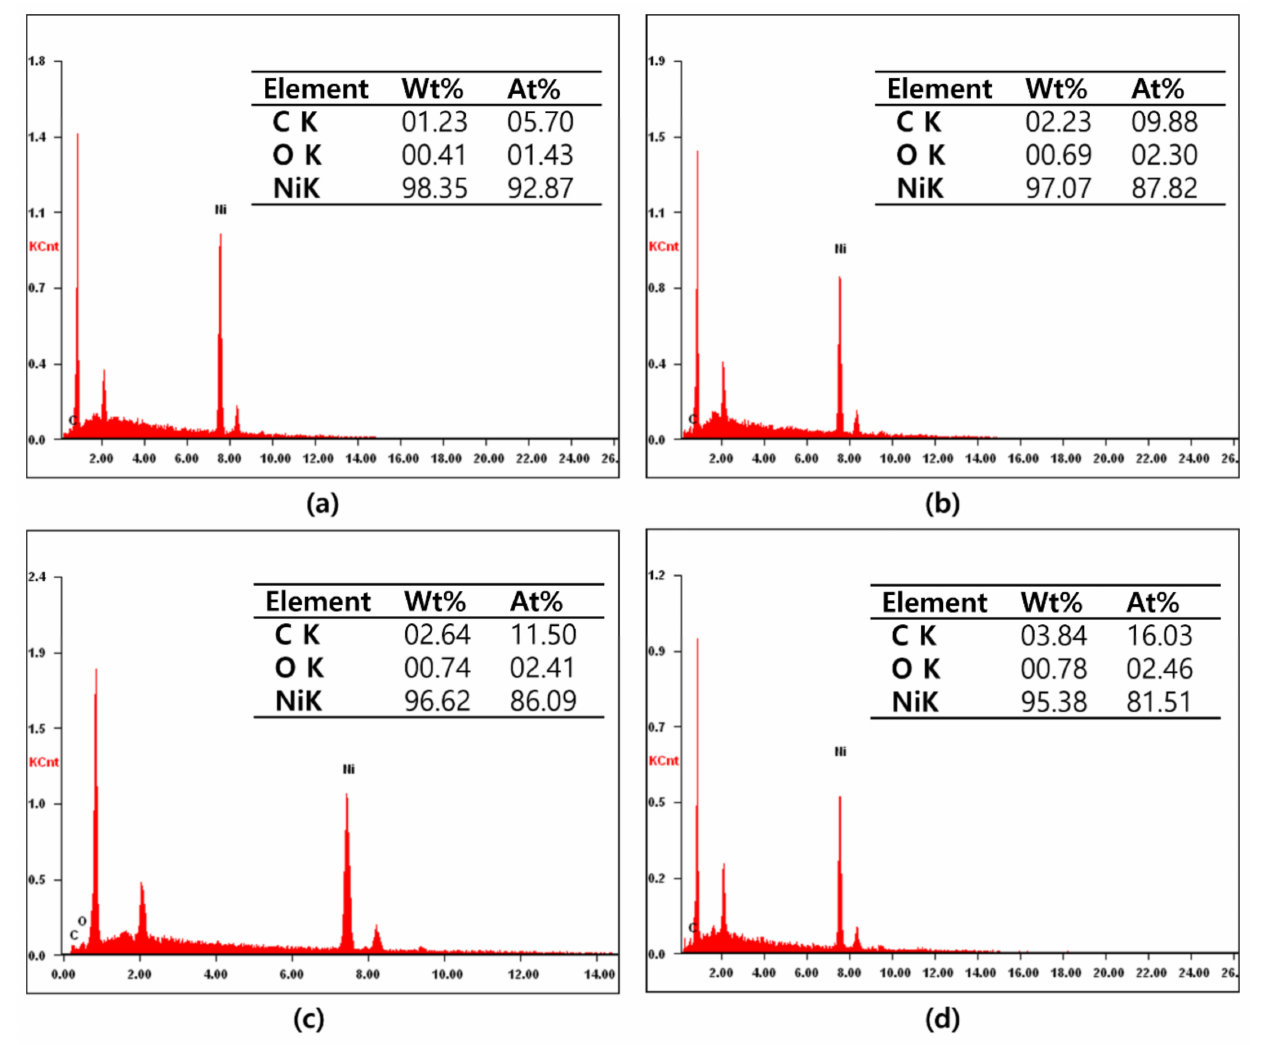
Figure 2. ( a – d ) EDS data of NICs prepared using TEG at carburizing process times of 15, 30, 45, and 60 min.